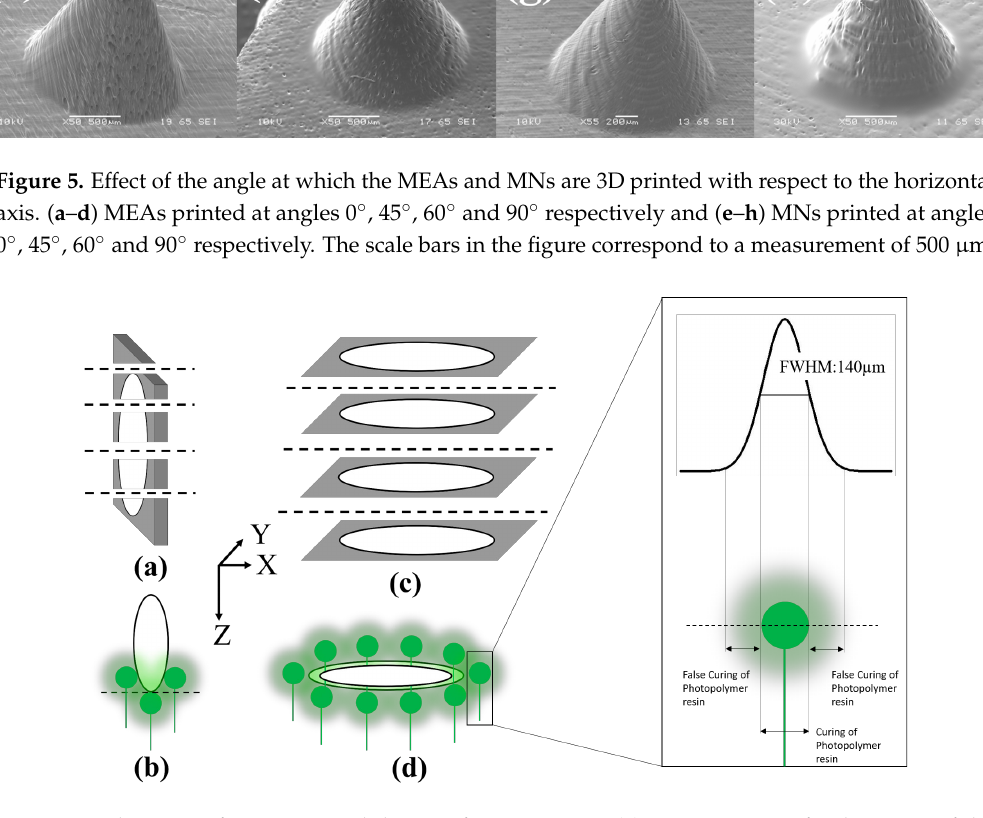
Figure 6. Schematic of our proposed theory of 3D printing—( a ) Cross-section of only an arc of the electrical via of the MEA; ( b ) curing in undesired locations of the photopolymer occurs and the arc of the via is not defined. When the print progresses the incomplete curing of a single layer propagates throughout the entire geometry of the vias resulting in a print failure; ( c ) vias are resolved in the XY-axis with the ( d ) diffraction effect altering the print dimensions in the XY-plane.